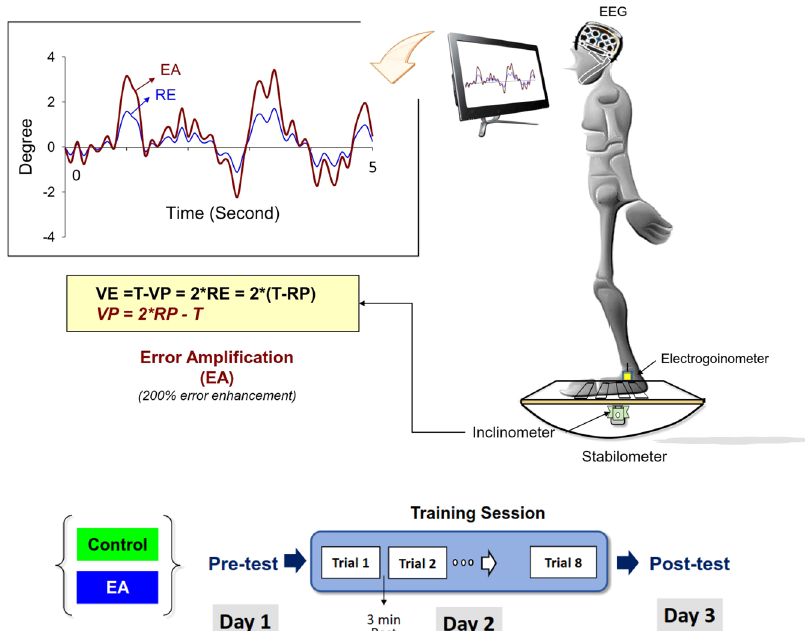
Fig. 4 System setup and experimental training protocol. The participants coupled the line of visualized postural sway (VP) to the target line (T) under the guidance of online visual feedback. Balance performance of the trained stabilometer task was measured in the pre-test (Day1) and post-test (Day 3). During the practice session (Day 2), the participants in the control group were trained with traditional visual feedback that displayed visualized errors (VE) equivalent to real errors (RE) in the computer monitor at eye level (VE = RE). By real-time mathematical transformation, the error ampli fi cation (EA) group were trained with visual feedback that virtually double the real errors (RE) during the training session (VE = 2*RE). (EA: error ampli fi cation, RP: real postural